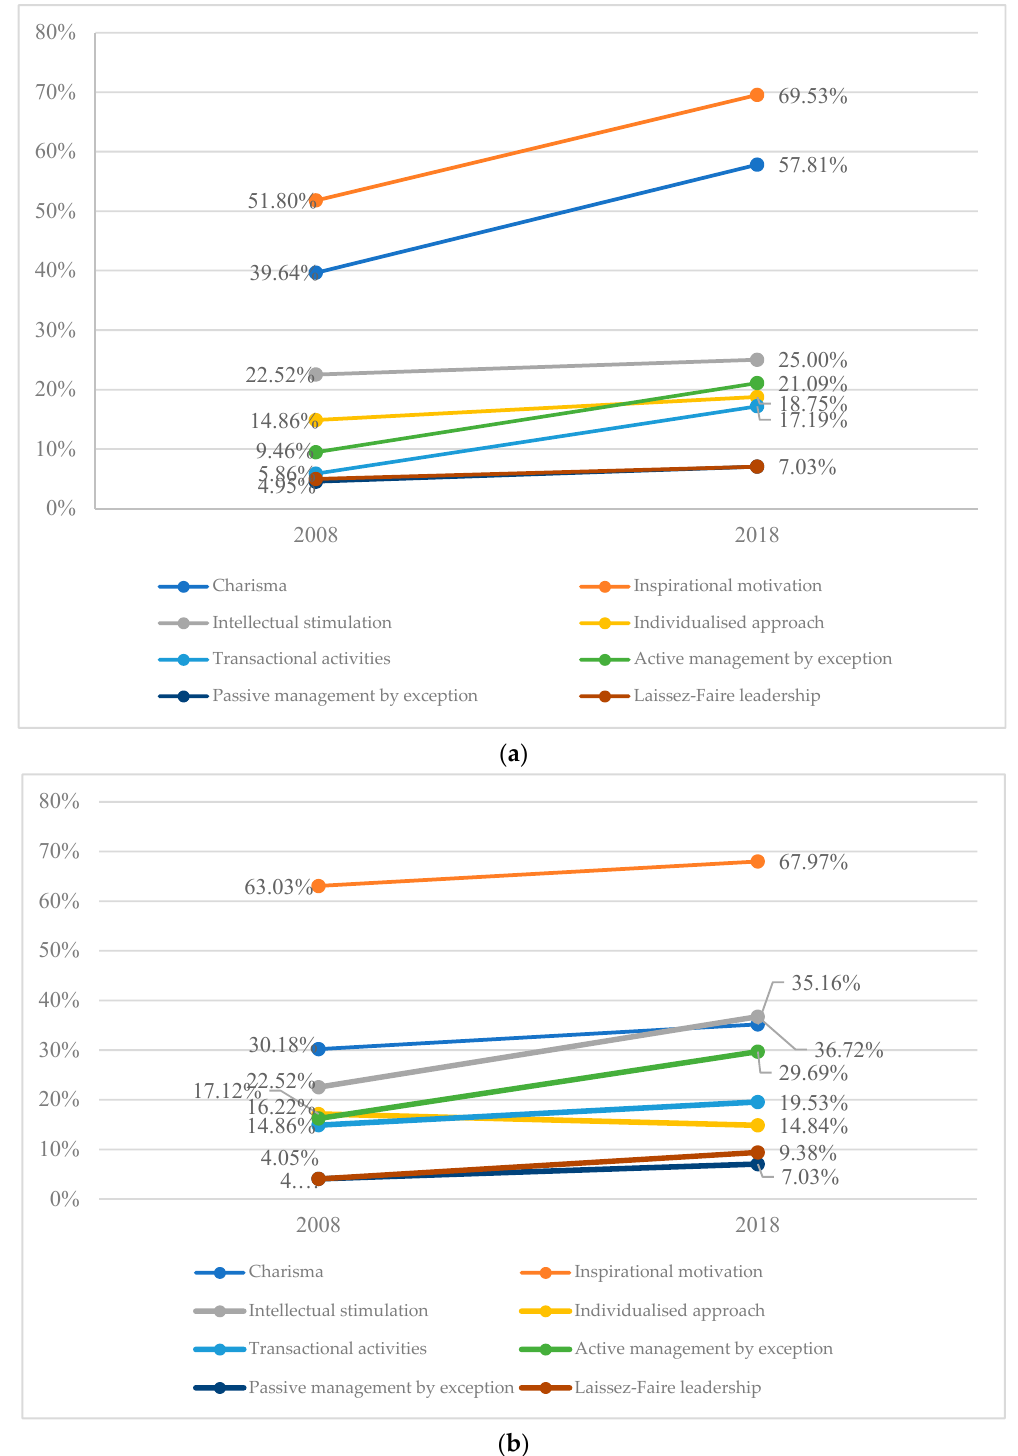
Figure 7. ( a ) Evaluation of the importance of leadership factors by leaders of the Forbes Global 2000 world’s largest corporations—general context. ( b ) Evaluation of the importance of leadership factors by leaders of the Forbes Global 2000 world’s largest corporations—corporate business context.